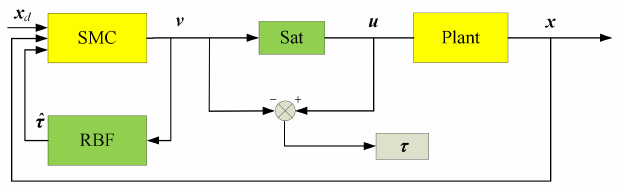
Figure 6. Structure of the closed-loop